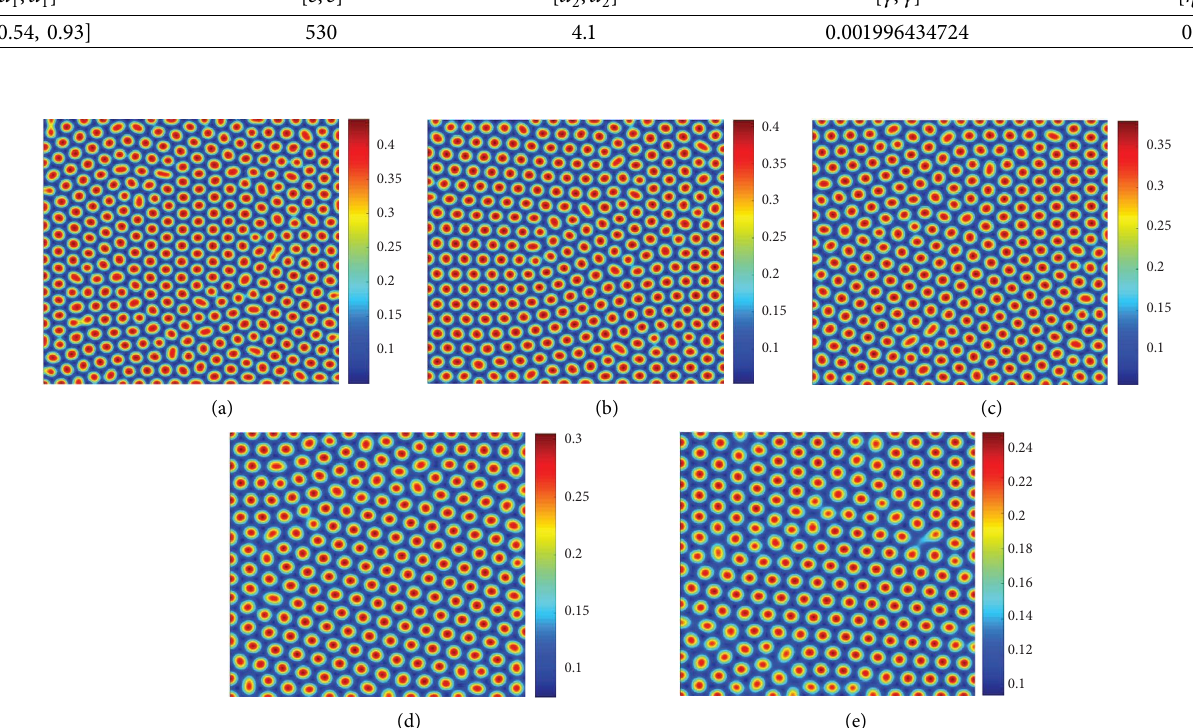
Figure 4: Patterns transitions induced by interval parameter d